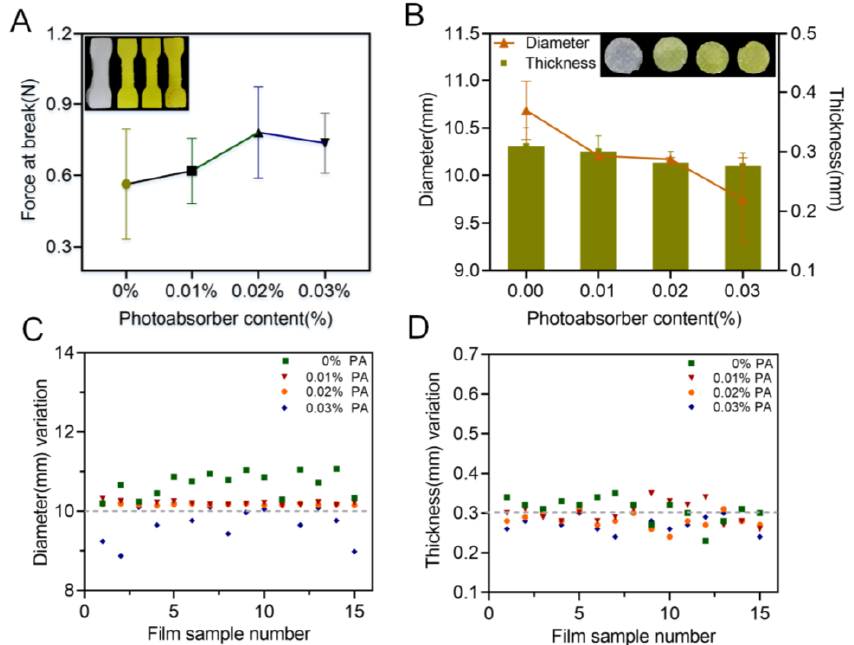
Figure 5. Effect of the photoabsorber on the printability: ( A ) force at break of specimen samples (n = 6); ( B ) thickness and diameter of 3D-printed oral film samples (n = 15); ( C ) diameter variations and ( D ) thickness variations of 3D-printed oral film samples.